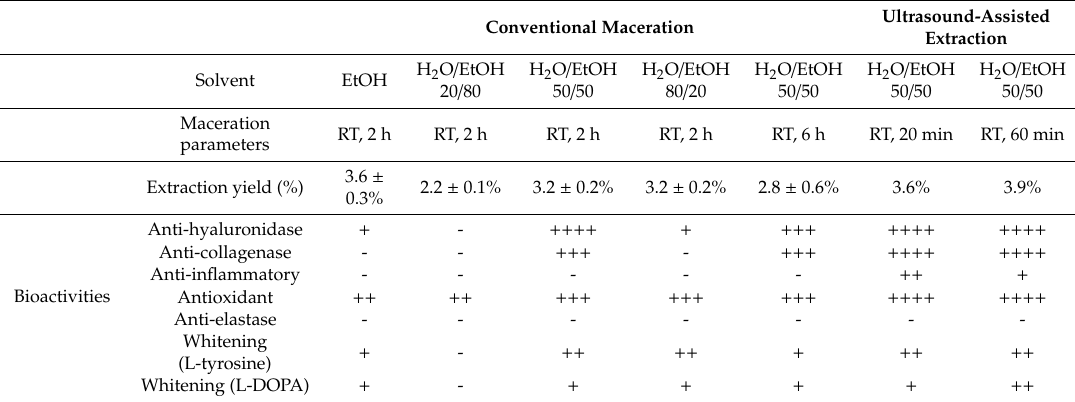
Table 3. Bioactivities of various R. nigrum pomace extracts obtained by conventional and ultrasound- assisted